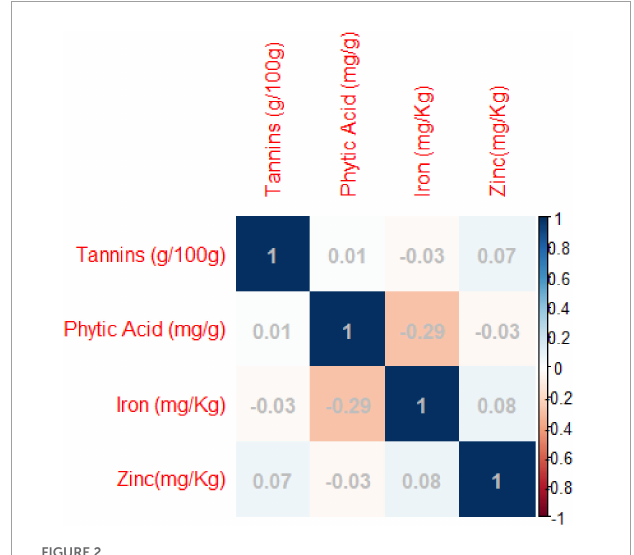
FIGURE2 Pearson’s correlation coefficients between investigated traits- Diagrammatic view PC1 = 32.95%, PC2 =